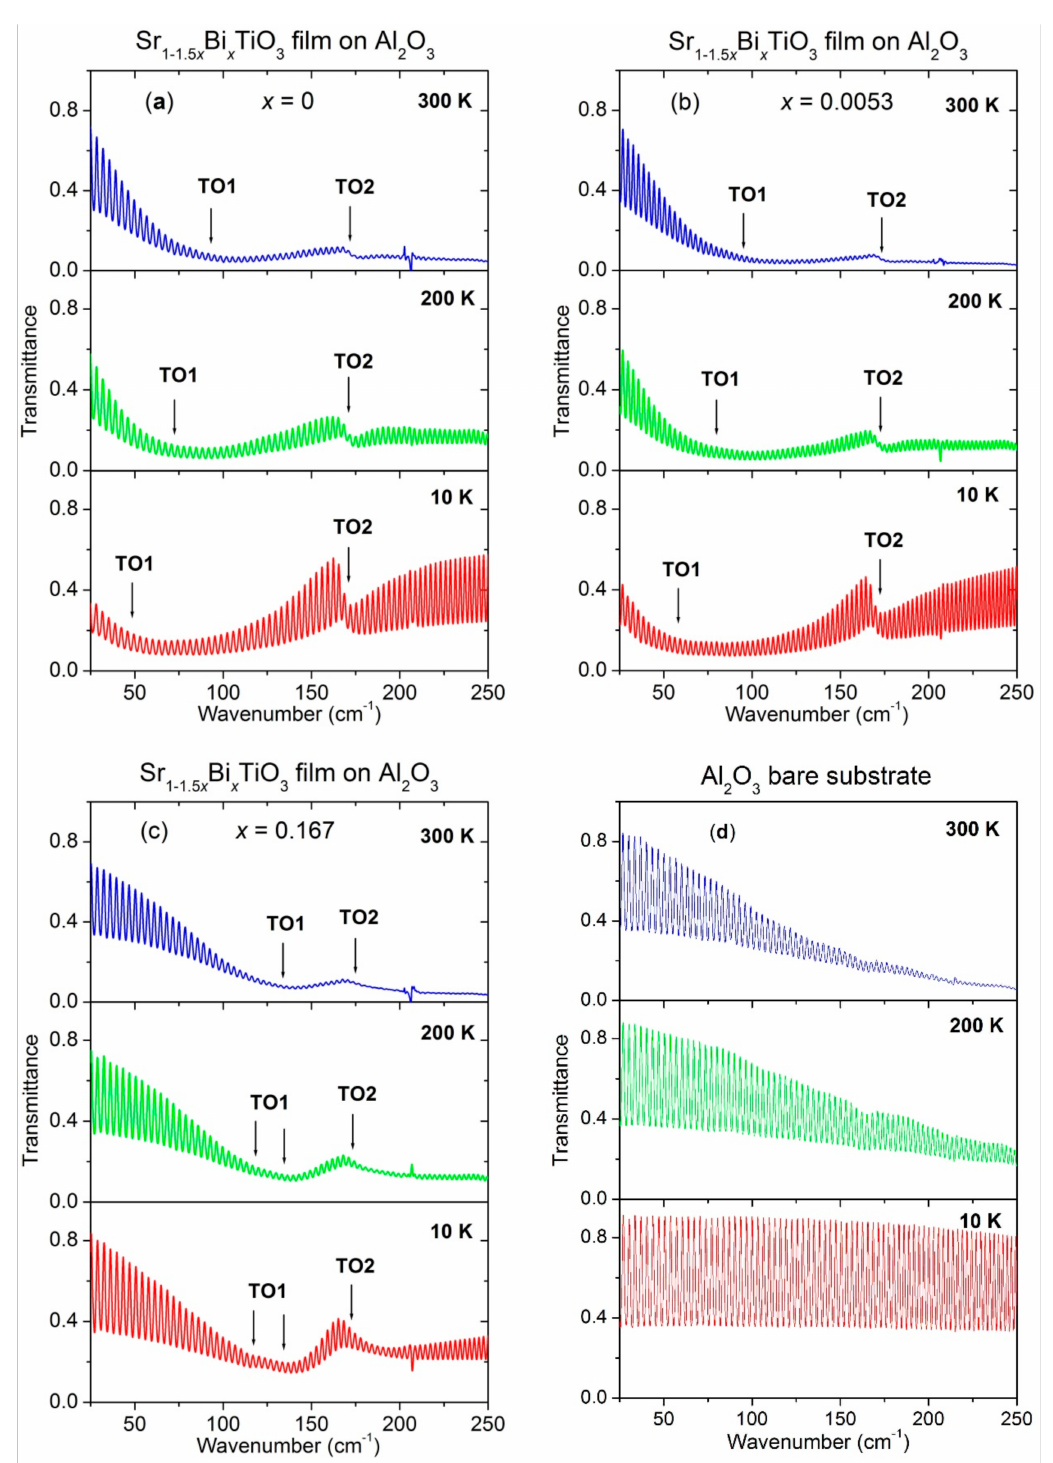
Figure 3. Infrared transmittance spectra at 300 K (top panel), 200 K (middle panel) and 10 K (bottom panel) of Sr 1 − 1.5x Bi x TiO 3 thin films with x = 0 ( a ), 0.0053 ( b ) and 0.167 ( c ) deposited on Al 2 O 3 substrates as well as of bare Al 2 O 3 substrate ( d